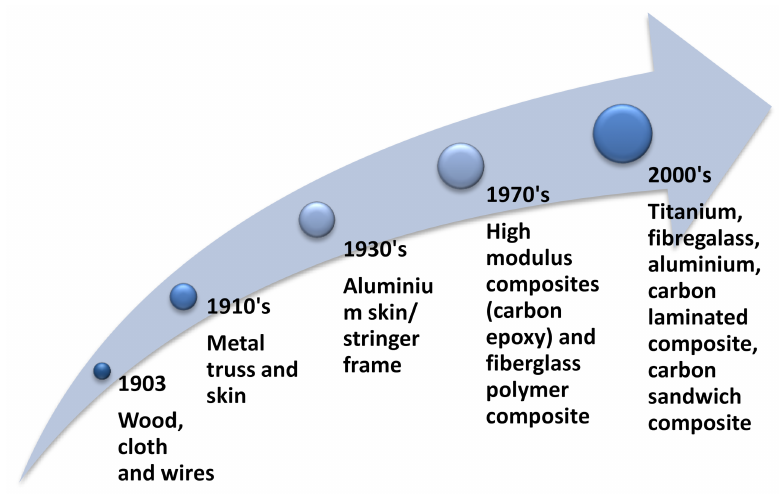
Figure 2. Evolution of materials used in the airframe structure